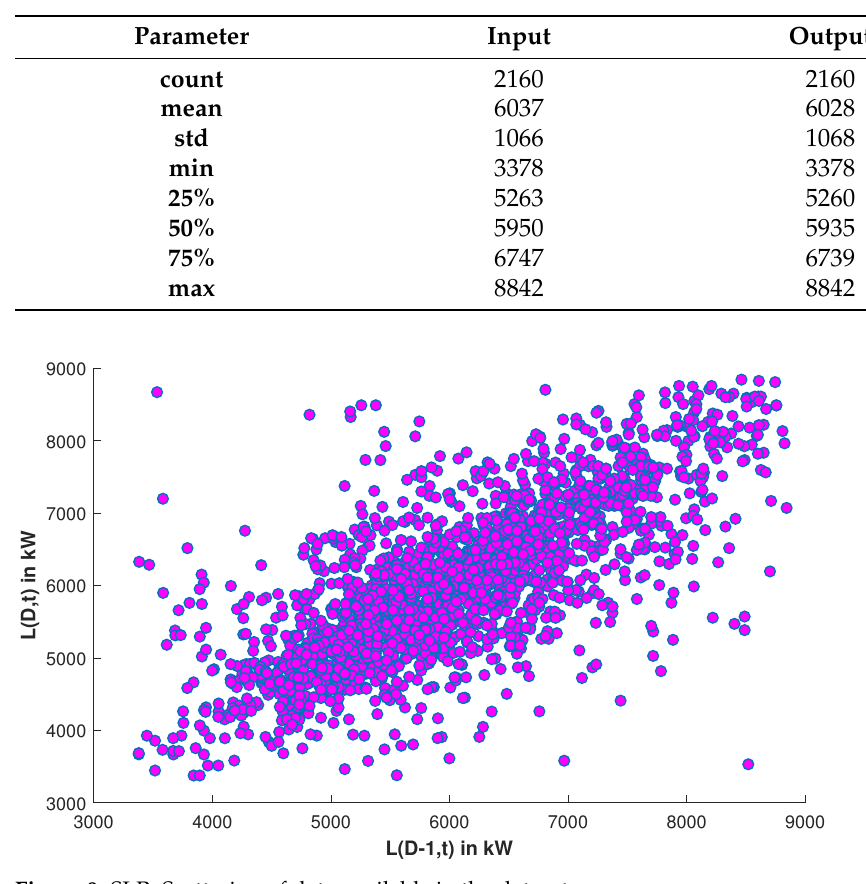
Figure 9. SLR: Scattering of data available in the dataset. Box plot and histogram plot have been used to observe the input and output data distribution. Input and output data histograms are presented in Figure 10, and it has been observed that both input and output data samples follow the normal